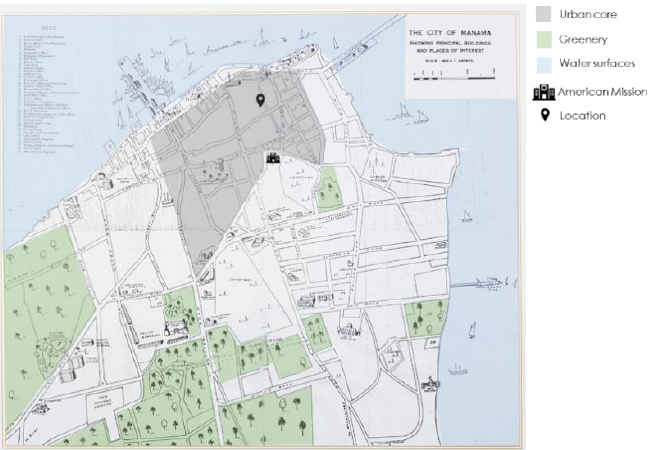
Figure 8: Existing soft scape in the British colony period end of 1960 . (Hamosh, Manama City Plans. Bahrain, 2009)